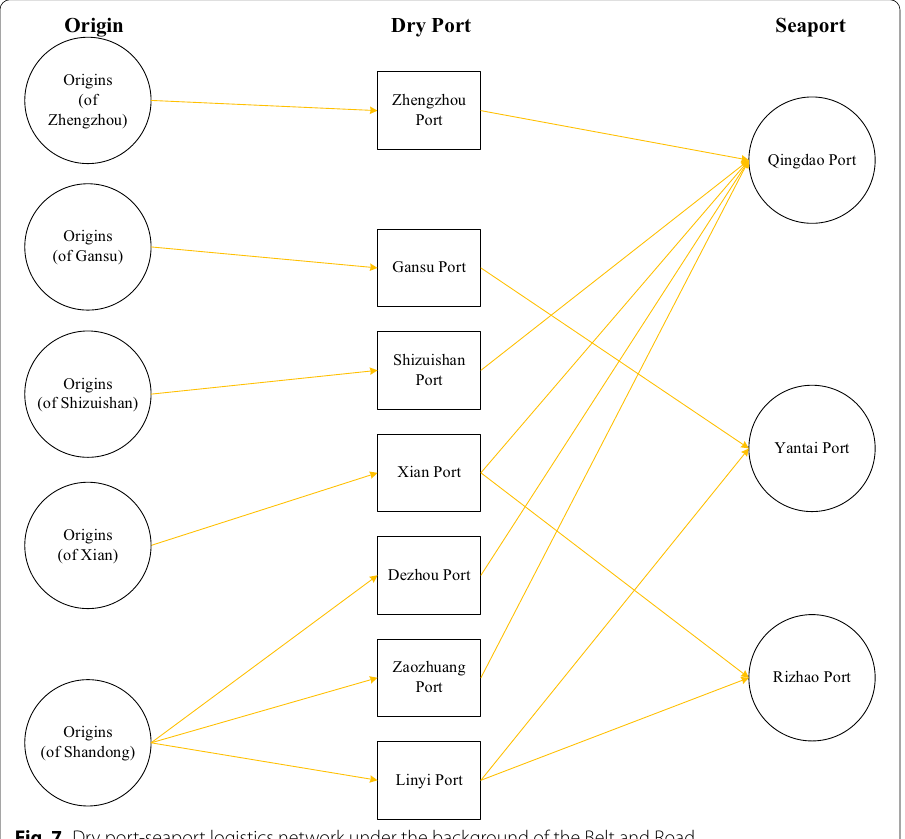
Fig. 7 Dry port-seaport logistics network under the background of the Belt and